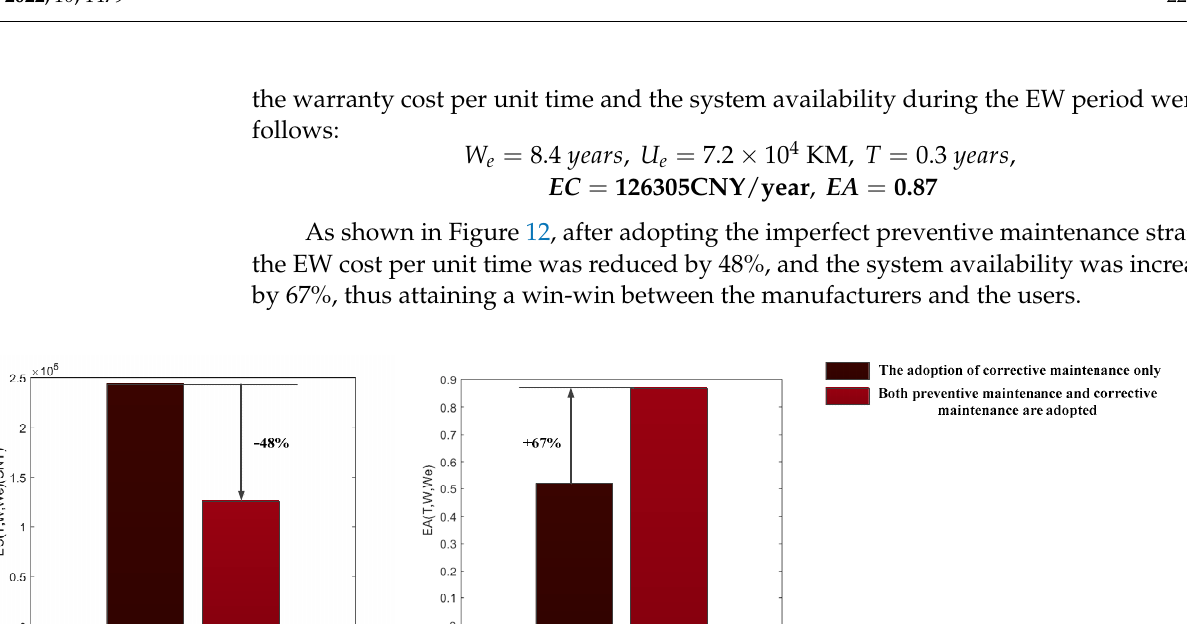
Figure 12. Comparison between systems with and without preventive maintenance.